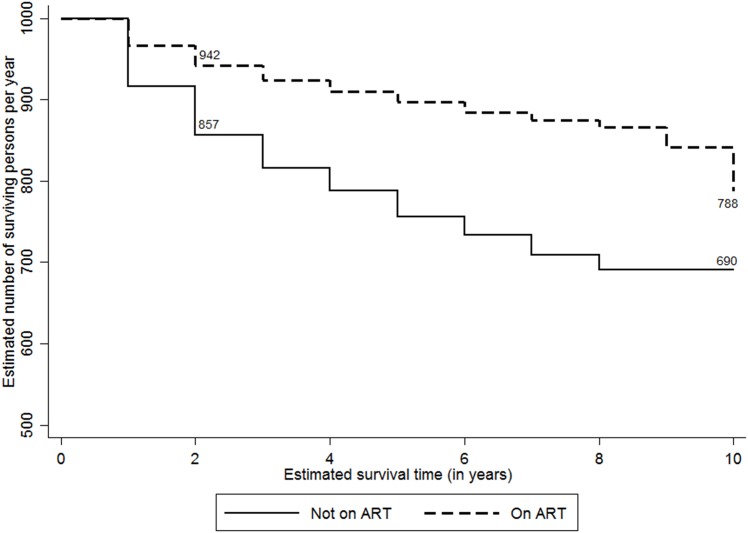
Adjusted Kaplan-Meier survival estimates by ART status (per 1000 persons per year).The line graph shows ten-year survival probability curves among PLHIV per 1000 persons per year since they tested positive for HIV by their ART status. The estimates are adjusted by the place of residence of PLHIV.